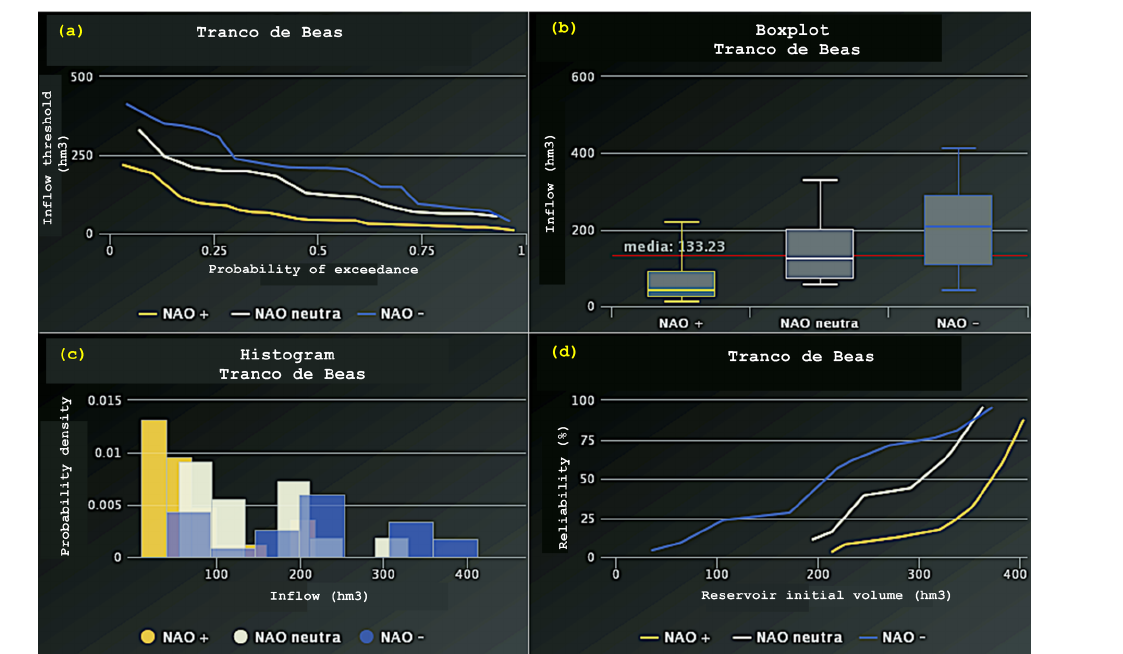
Figure 4. Top right panel in diagnostic view. Four indicators show the distribution of observed precipitation or water reservoir inflow according to NAO phase displayed in the diagnostic view of S-ClimWaRe web toolbox.